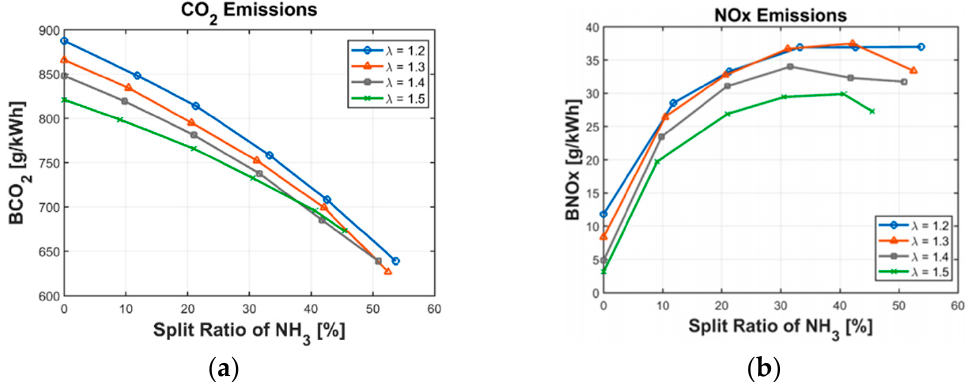
Figure 4. Effect of volume fraction of ammonia and air coefficient. ( a ) on CO 2 emissions; ( b ) on NOx emissions.